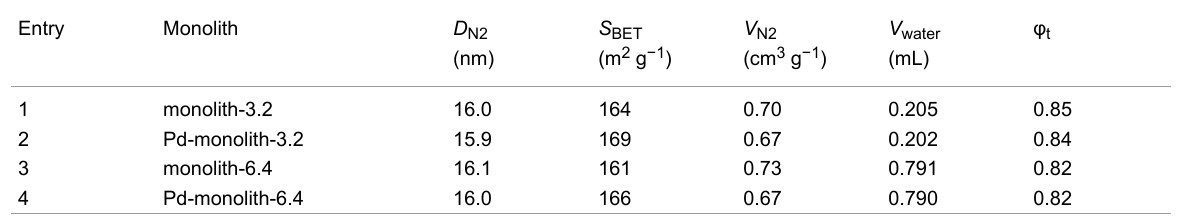
Table 1: The main characteristics of monoliths characterized by N 2 adsorption at 77 K. a